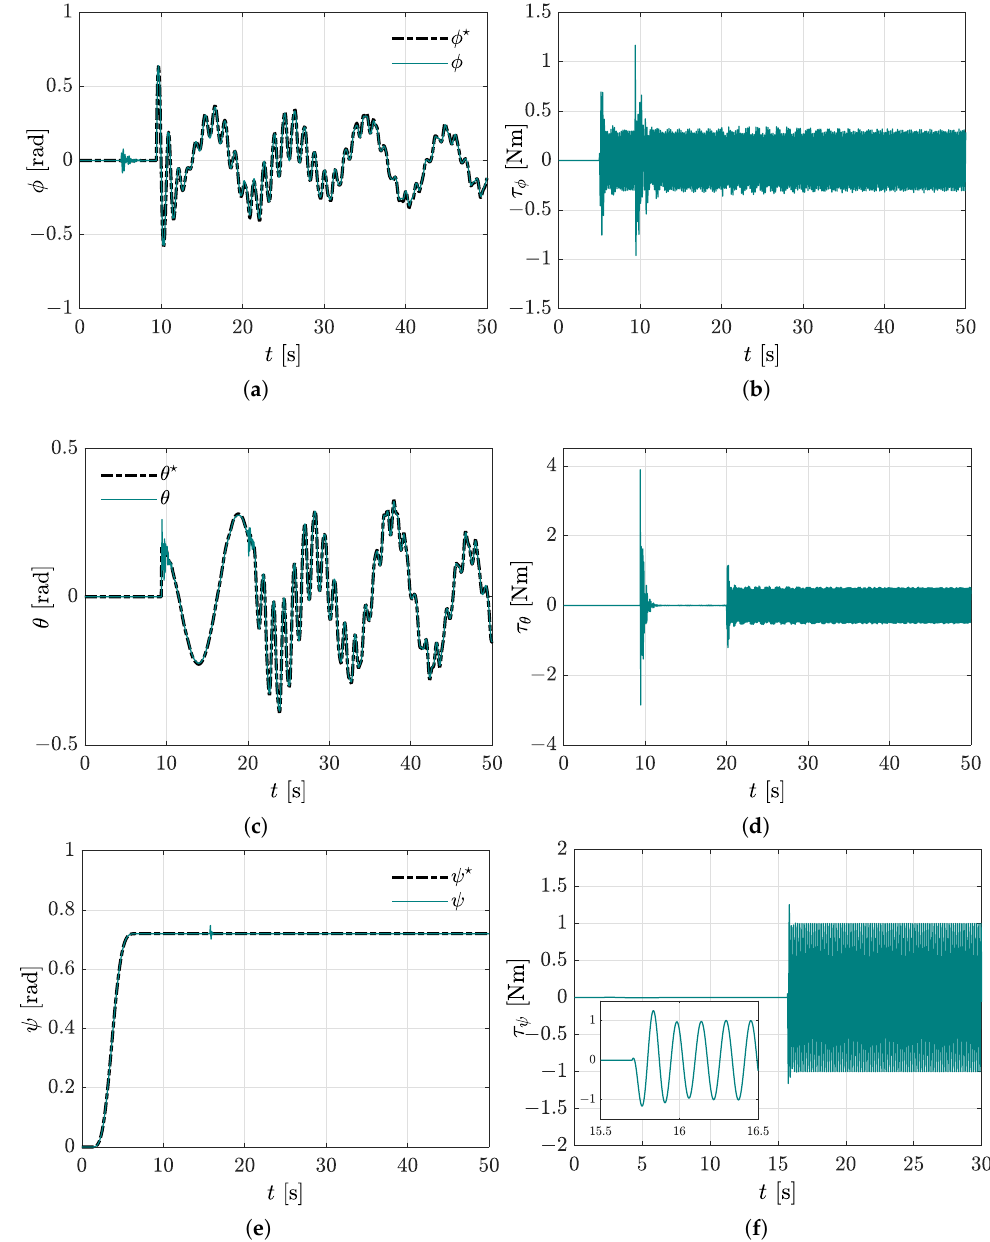
Figure 14. Perturbed angular dynamics, case 2.3. ( a ) Tracking of the desired φ angle. ( b ) Computed control input τ φ . ( c ) Tracking of the desired θ angle. ( d ) Computed control input τ θ . ( e ) Tracking of the desired ψ angle. ( f ) Computed control input τ ψ